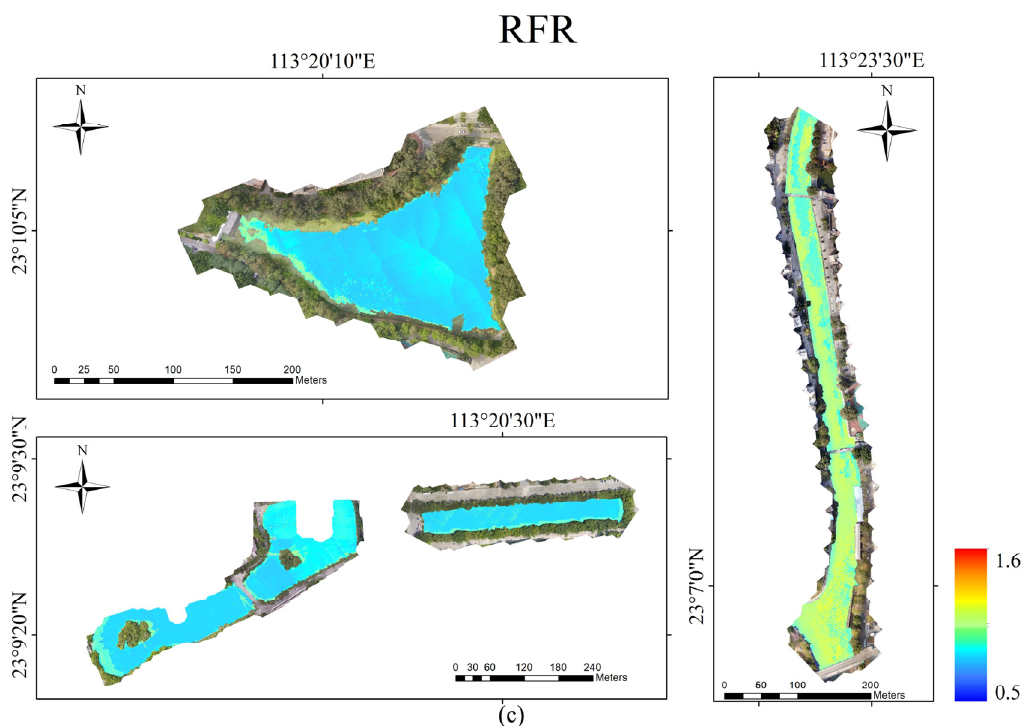
Figure 7. Inversion map of NCPI on the basis of UAV-borne images and 3 different models. ( a ) XGBR; ( b ) SVR; ( c ) RFR.